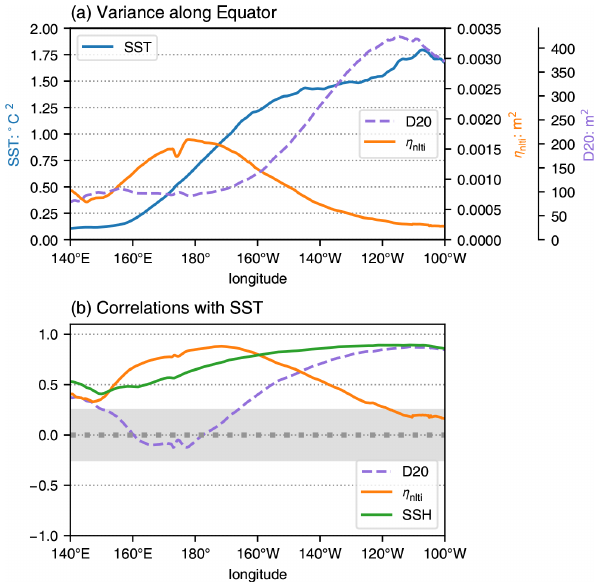
Figure 3. (a) The variance of detrended time series of monthly mean anomalies of SST (blue), η nlti (orange), and D20 (dashed) as a function of longitude along the Equator in the NEMO model simu- lation. (b) Same as (a) but for the correlation of the different indices with SST. The units in (a) are ( ◦ C) 2 (left-hand scale) for SST and m 2 (right-hand scale) for D20 and η nlti . Correlations in (b) that are outside the grey shaded region are significantly different from 0 at the 95%